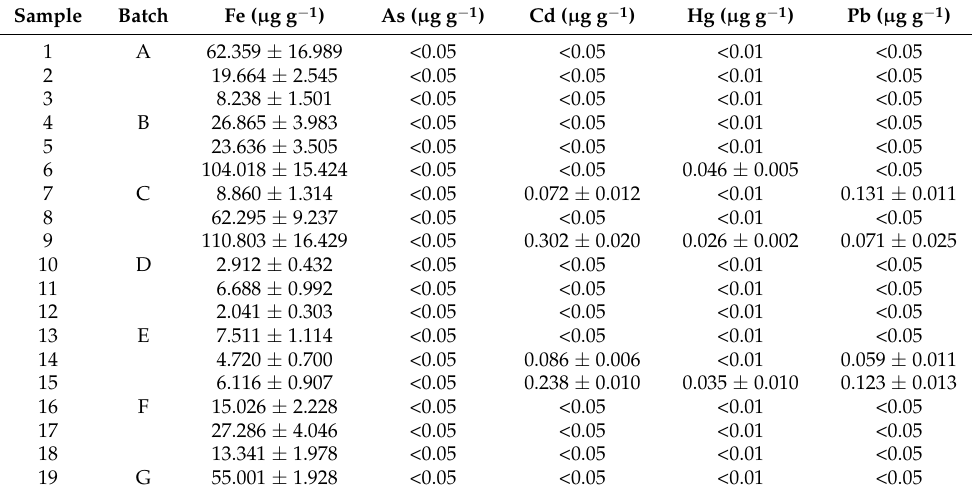
Table 7. Concentration of metals content (iron, Fe; arsenic, As; cadmium, Cd; mercury, Hg and lead, Pb expressed as µ g g − 1 DW) for sample. Values are given as samples mean ± SD (standard deviation, n = 3). Values higher than that allowed by Commission Regulation (EC) No 1881/2006 of 19 December 2006, setting maximum levels for certain contaminants in foodstuffs (http://data. europa.eu/eli/reg/2006/1881/2022-01-01, accessed on 1 December 2022).